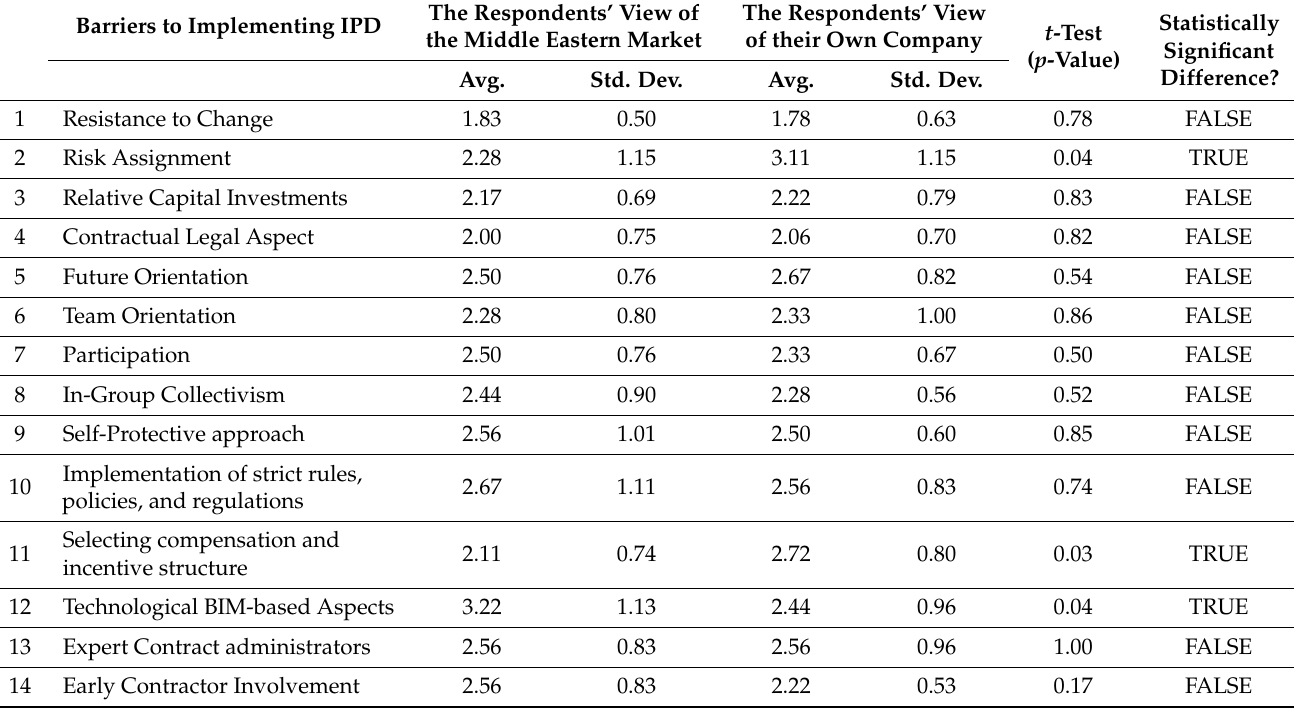
Table 5. Summarizing the Analysis results into two